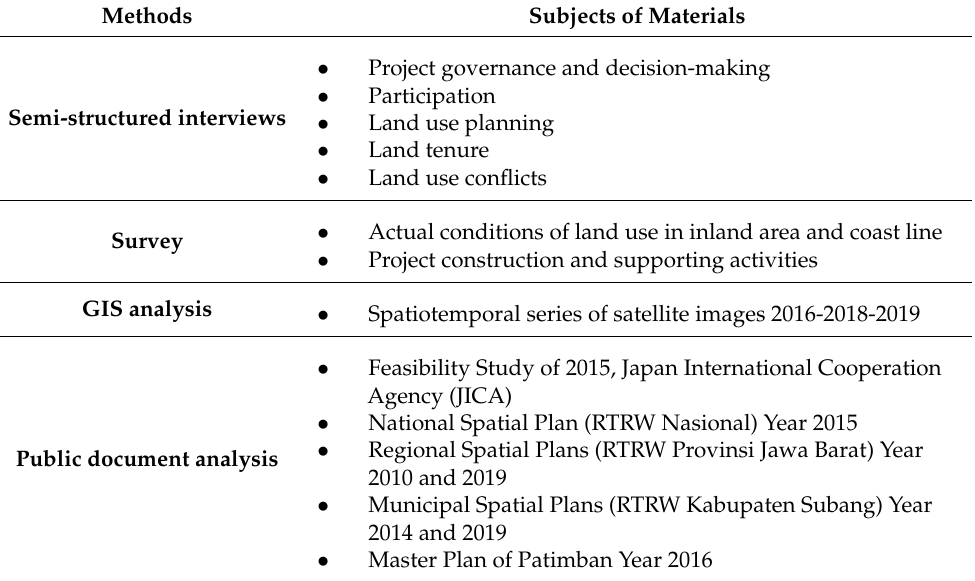
Table 2. Materials and Methods.